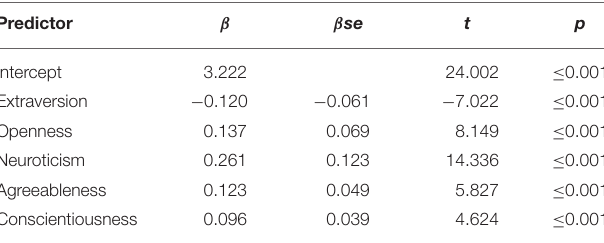
TABLE 4 | Regression analysis to predict the ASB by the Big Five traits. Predictor